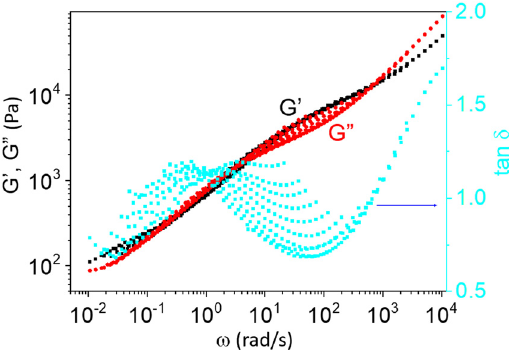
Figure A3: Master curve of ( S 15.4 - 0.48 - B 16.7 ) 3 with G ′ , G ″ , and tan δ versus angular frequency ( ω ) with the reference temperature at 150°C.